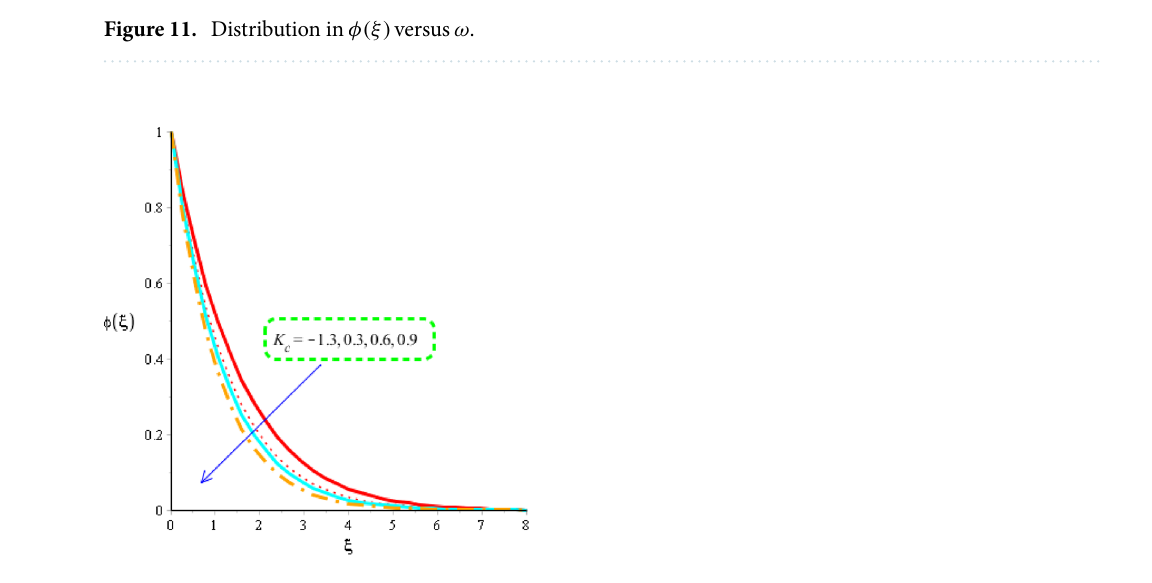
Figure 12. Distribution in φ(ξ) versus K c